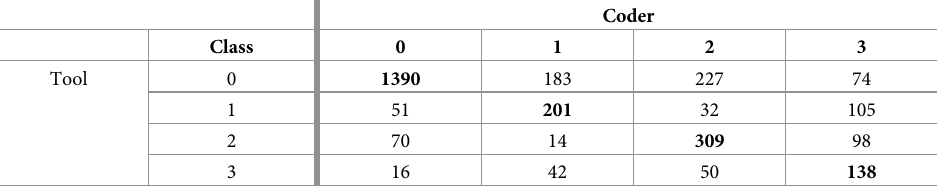
Table 1. Confusion matrix for the best detection model; each element is shown in terms of number of 15 seconds